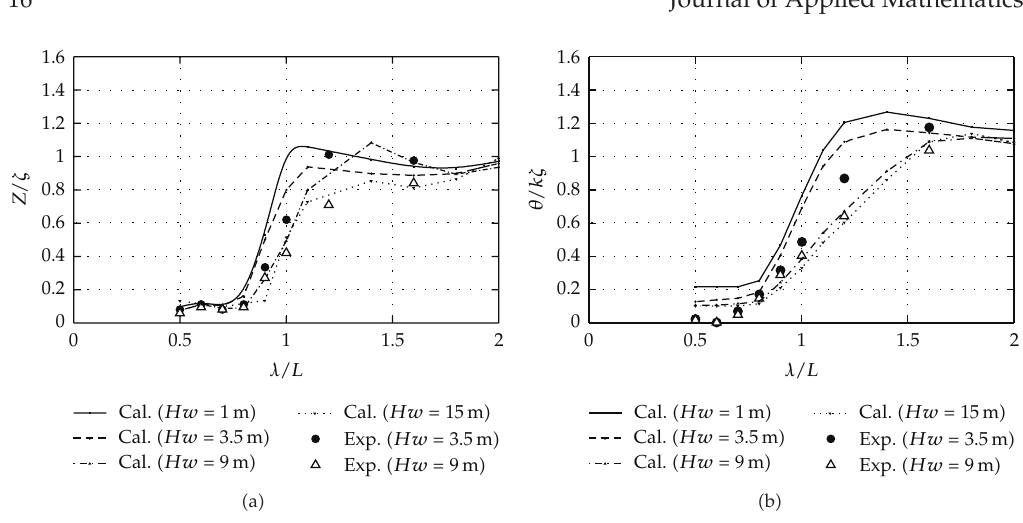
Figure 11: (cid:5) a (cid:6) The e ff ect of wave height on the response amplitude operator of heave (cid:5) χ (cid:7) 180deg., F n (cid:7) 0 . 239 (cid:6) , (cid:5) b (cid:6) The e ff ect of wave height on the response ampilitude operator of pitch (cid:5) χ (cid:7) 180deg., F n (cid:7) 0 . 239 (cid:6)